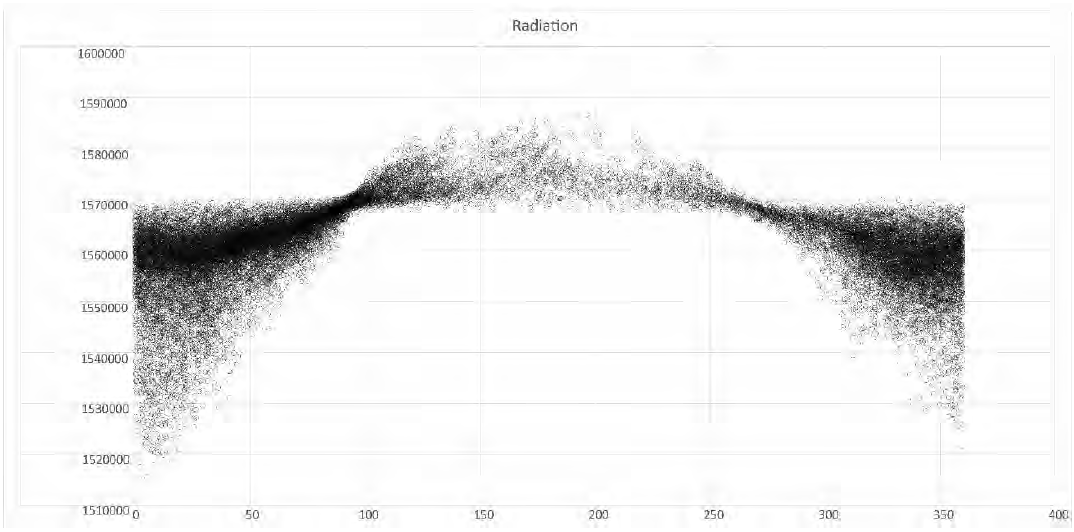
Figure 6. The amount of solar radiation relative to the earth